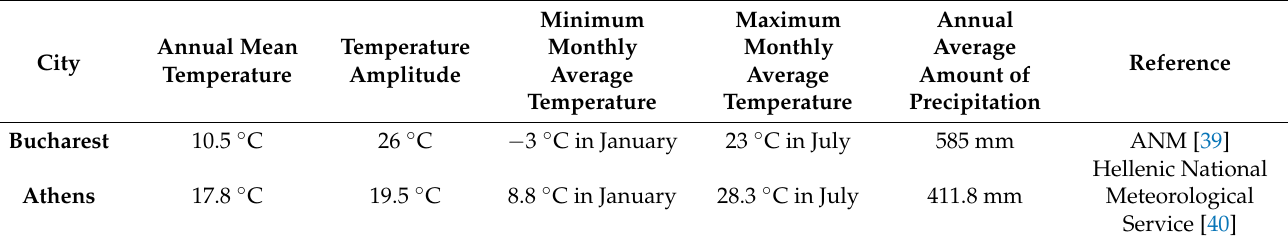
Table 1. Climatic characteristics of Bucharest and